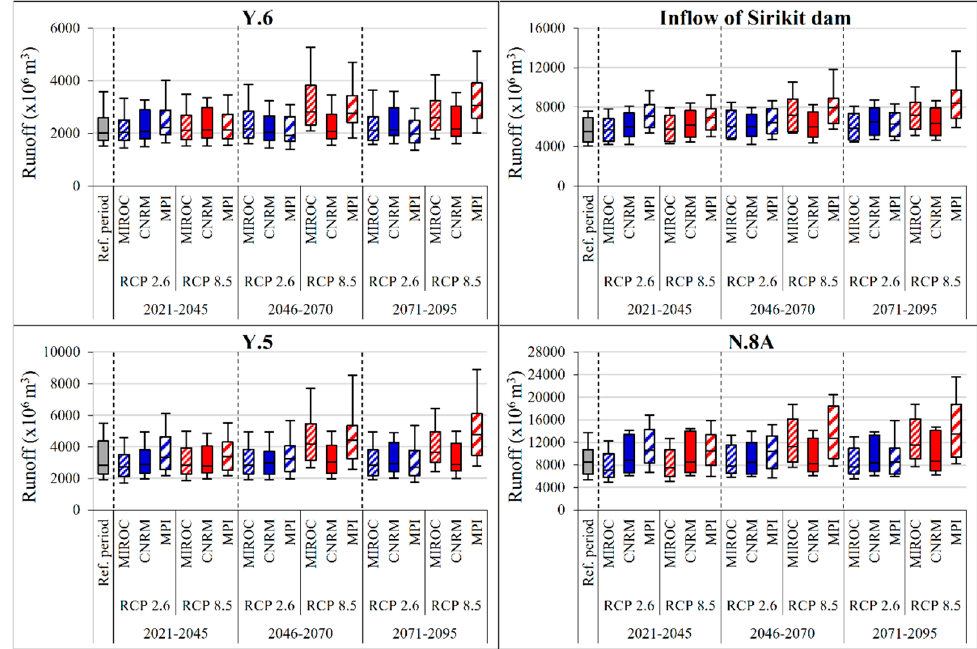
Figure 6. Annual runoff in the reference period (1981–2005) with the near future, intermediate future, and far future under RCP 2.6 and RCP 8.5.